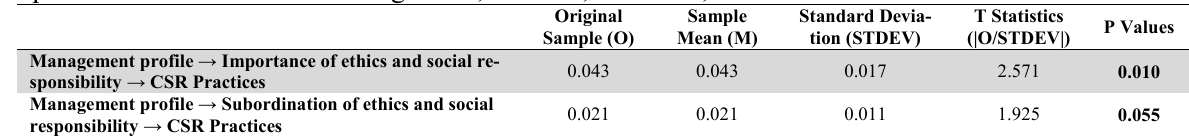
Specific Indirect Effects including Mean, STDEV, T-Values, P-Values